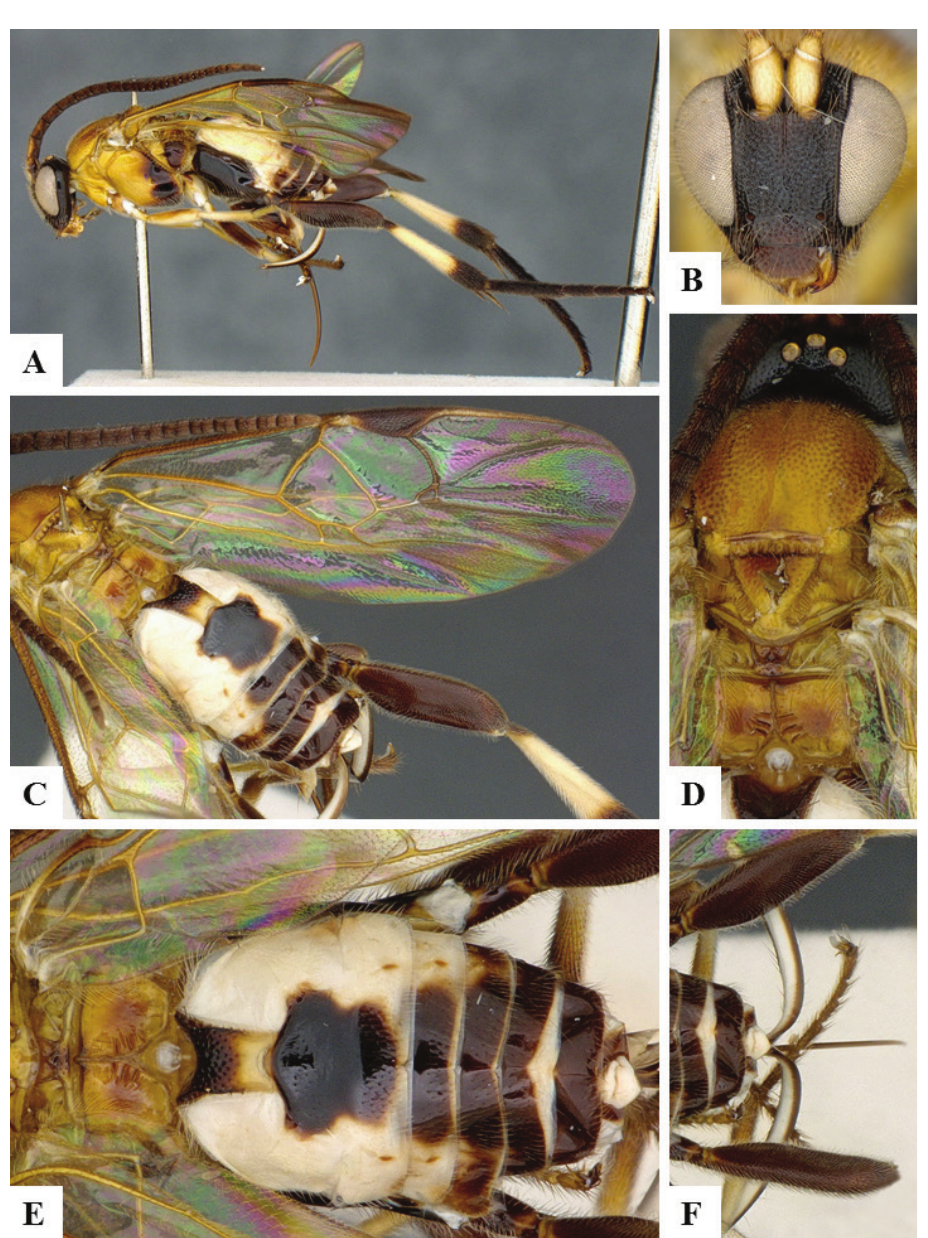
Figure 6. Agupta raymondi female holotype. A Habitus B Head frontal C Fore wing D Mesosoma dorsal E Propodeum and metasoma, dorsal F Ovipositor and ovipositor sheaths. Molecular data. The holotype rendered an almost complete DNA barcode (596 bp), which represents a unique BIN (BOLD:ADE1550), with 5.3% of bp difference compared to the next species in BOLD, which is another Agupta species.